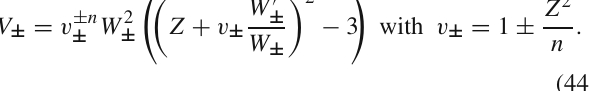
This result is consistent with Eq. (A5b) given that its last